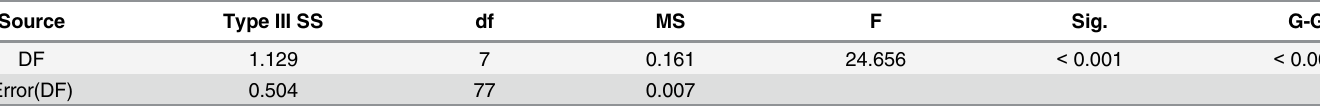
Table 3. One-way repeated measures ANOVA of proportion integrated for the factor Δ f (eight conditions, see Fig 9A). Analysis shows a significant effect of Δ f on proportion integrated. Data for N = 12 subjects, see text. Mauchly test for sphericity reaches significance, Greenhouse-Geisser correct P -value reported in the text.